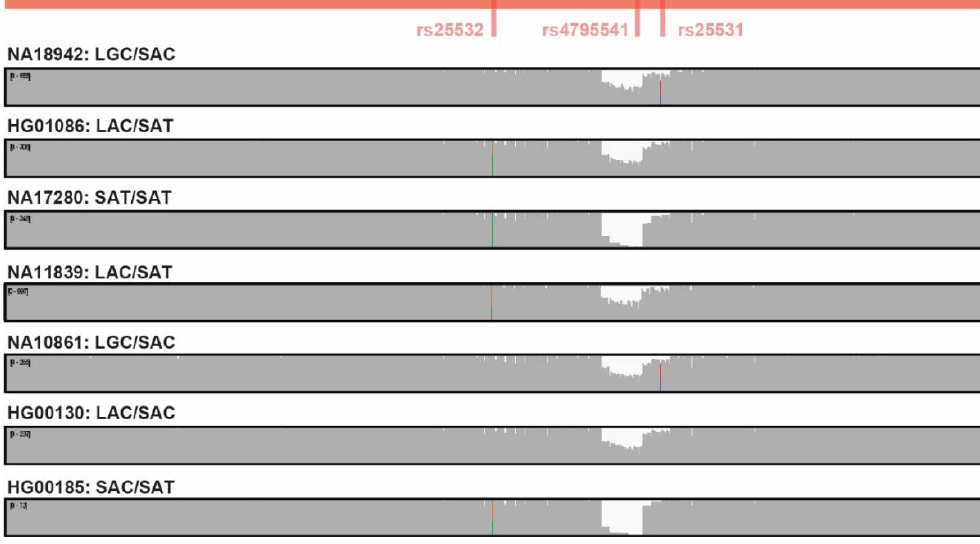
Table 2. SLC6A4 promoter haplotypes detected by SMRT sequencing. LAC